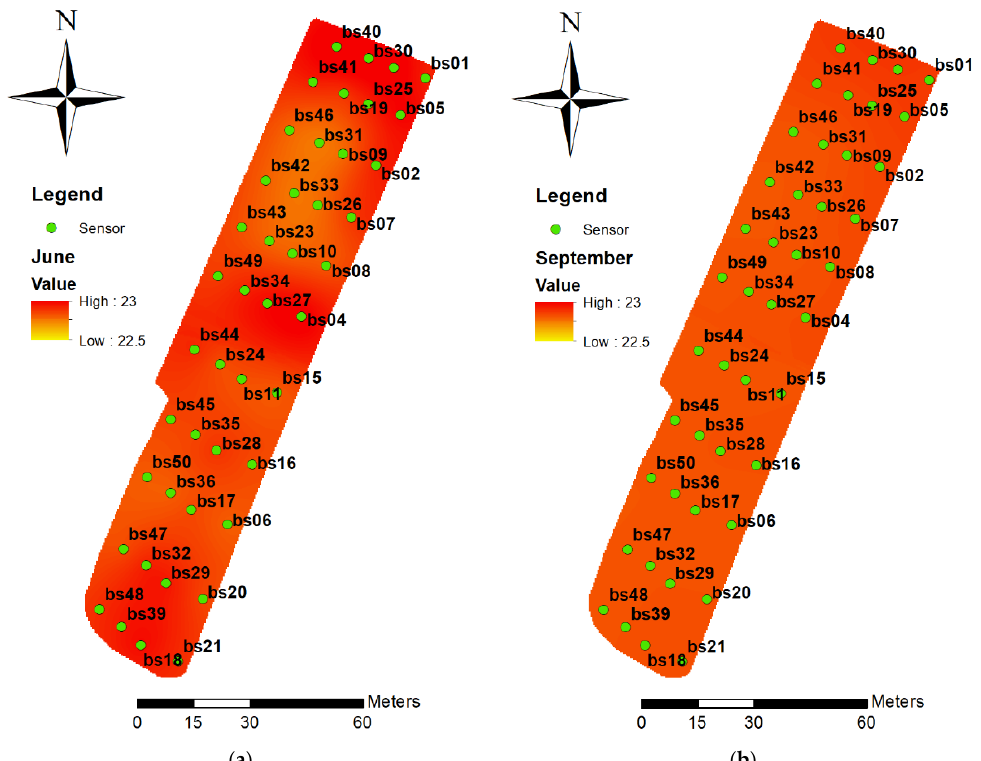
Figure 8. The kriging results for the greenhouse temperatures ( a ) June 14th from 12:00 a.m.—00:55 a.m. (summer); ( b ) September 14th from 12:00 a.m.—00:55 a.m. (autumn).